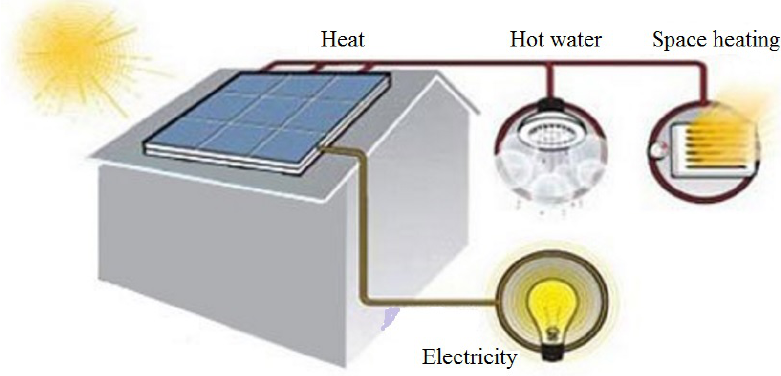
Figure 7. PV/T roof-top array supplying heating and electricity to